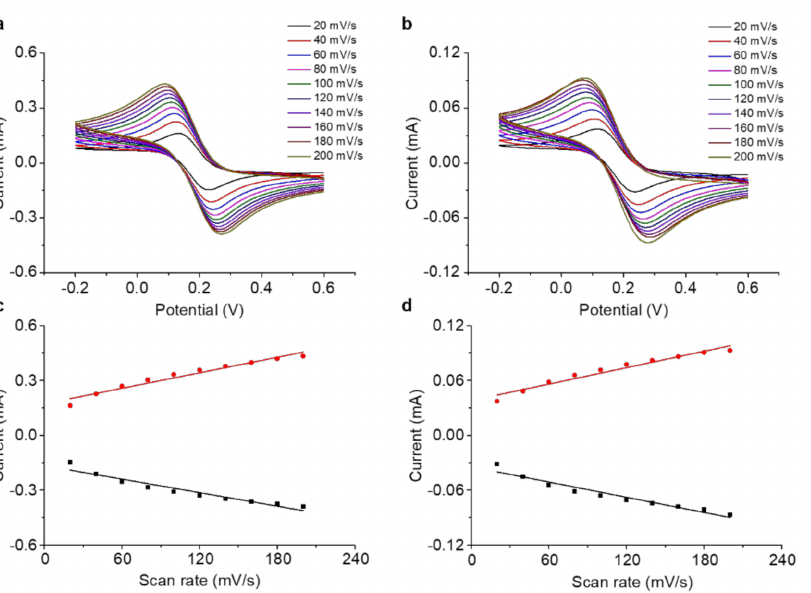
Figure 1. Cyclic voltametric curves of ( a ) aptasensor 1 and ( b ) aptasensor 2 with different scanning rates. Plotting the current intensity of ( c ) aptasensor 1 and ( d ) aptasensor 2 as a function of potential. The impedance of the HbA 1c aptamer sensor in HbA 1c protein solutions with concen- trations of 5.0, 10.0, 20.0, 30.0, and 40 µ g/mL and the Hb aptamer sensor in Hb protein so- lutions with concentrations of 62.5 µ g/mL, 125.0 µ g/mL, 250.0 µ g/mL, 500.0 µ g/mL,